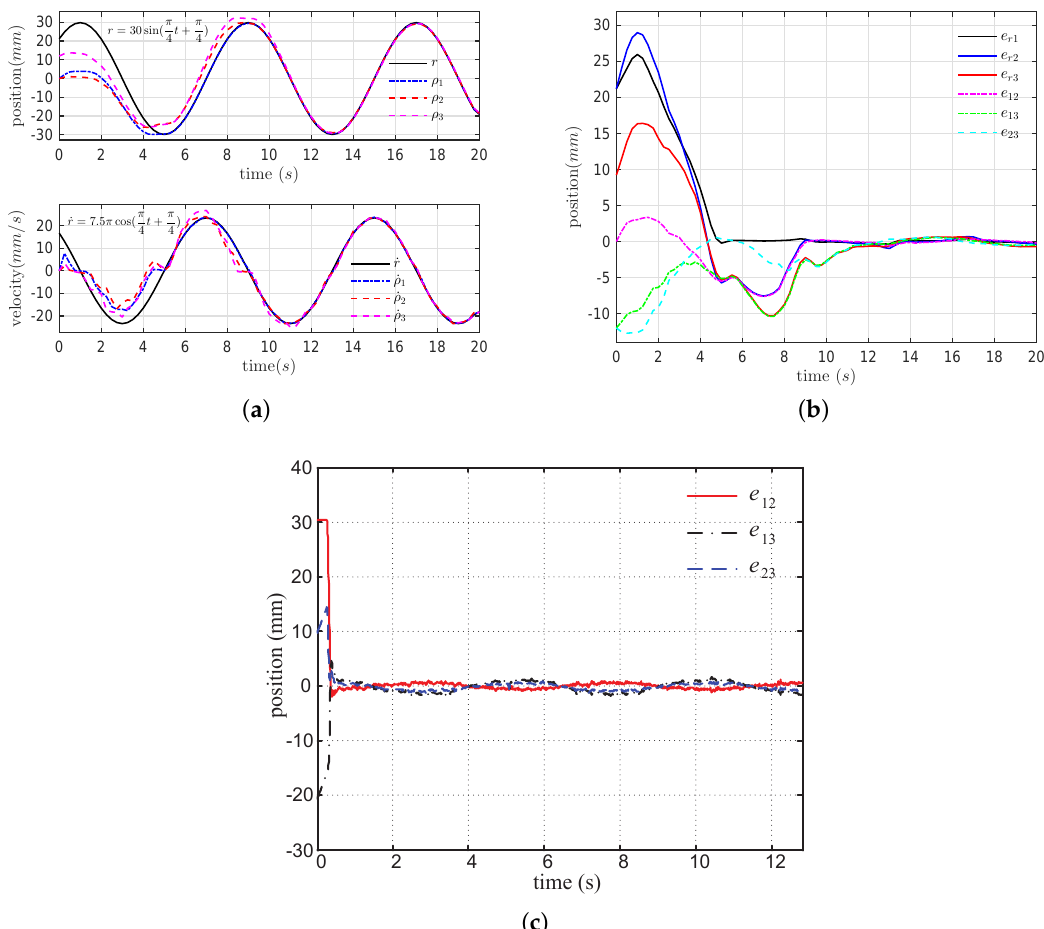
Figure 8. Position and velocity of reference and three LSRMs corresponding with Example